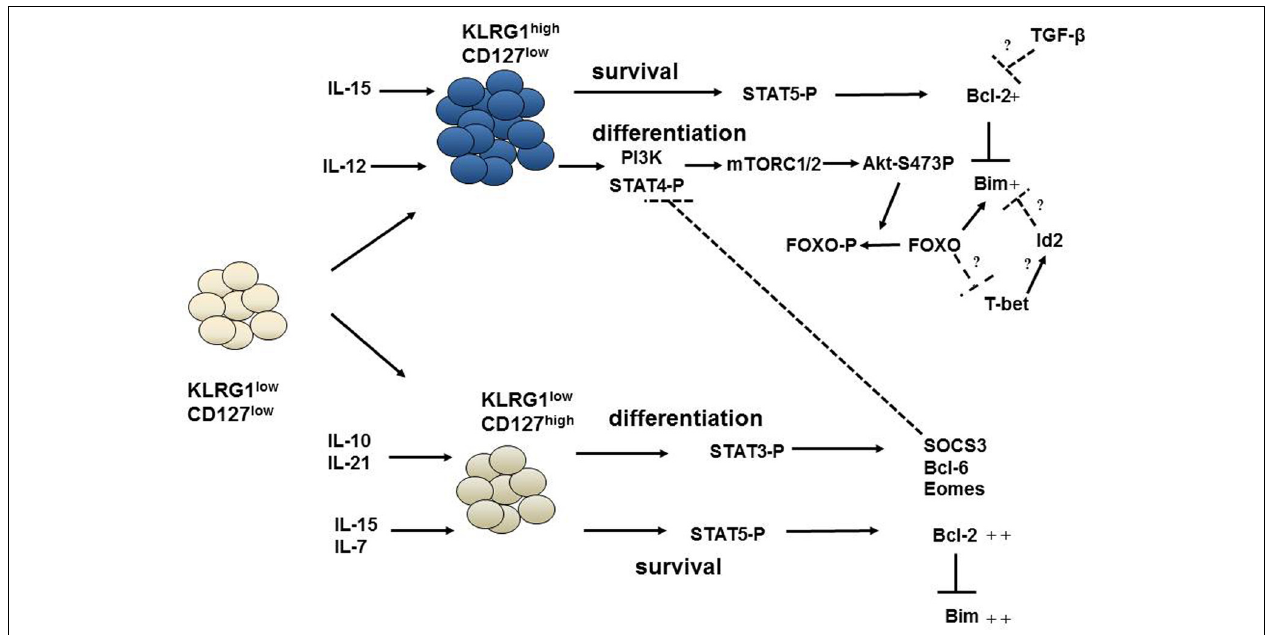
FIGURE 2 | Pathways governing the survival and differentiation of effector CD8 + T cells. The differentiation of early effector cells (KLRG1 lo CD127 lo ) into KRLG1 hi CD127 lo or KLRG1 lo CD127 hi cells is regulated by inflammatory cytokines and by IL-10 and IL-21. IL-12 can activate STAT4 and PI-3K signaling which modulates mTOR kinases and subsequent Akt phosphorylation at s473. Phosphorylated Akt can phosphorylate and inactivate FOXO proteins.This favors an increased t-bet:eomes ratio and differentiation into KLRG1 hi CD127 lo cells. On the other hand, Stat3 phosphorylation by IL-10 and IL-21 increases eomes and other transcription factors required for differentiation of KLRG1 lo CD127 hi cells. SOCS3 induced by Stat3 can, then, inhibit IL-12 signaling, effectively shielding KLRG1